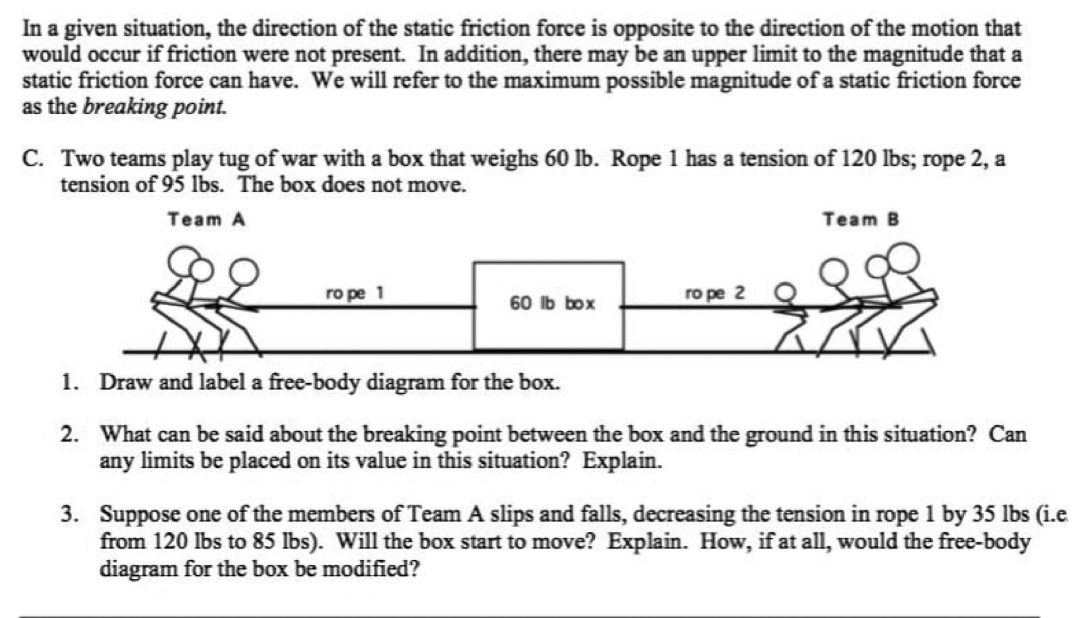
FIG. 3. Extended excerpt from static friction tutorial based on the difficulties